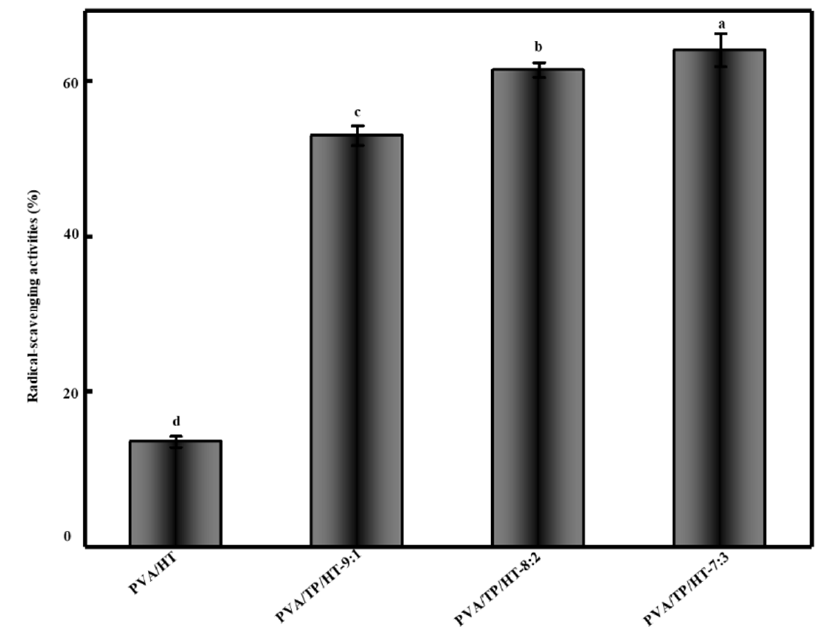
Figure 6. Trend of radical-scavenging activities. Data followed by different lowercase letters were significantly different ( p < 0.05) when comparing the radical-scavenging activities of nanofiber film.